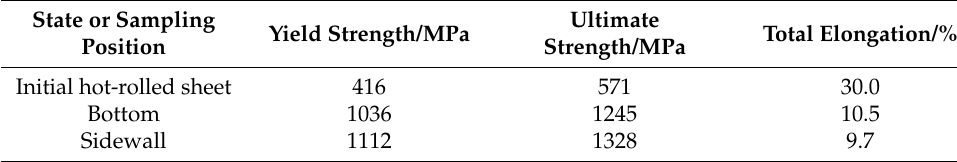
Figure 11. OM images at the bottom ( a , b ) and sidewall ( c , d ) of the U-shaped part. Table 3. Tensile properties of the initial sheet and the thermoformed U-shaped